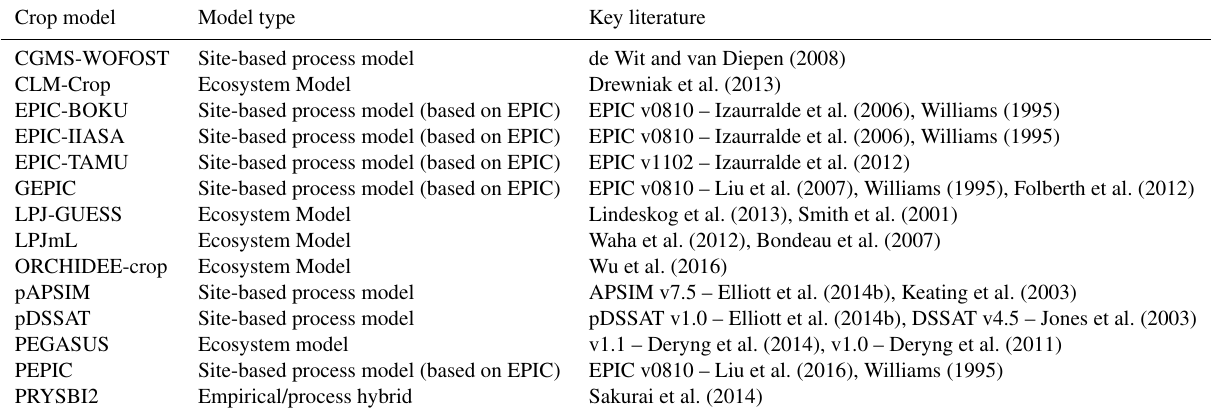
Table 1. GGCMs participating in the study, model type and key references. Crop